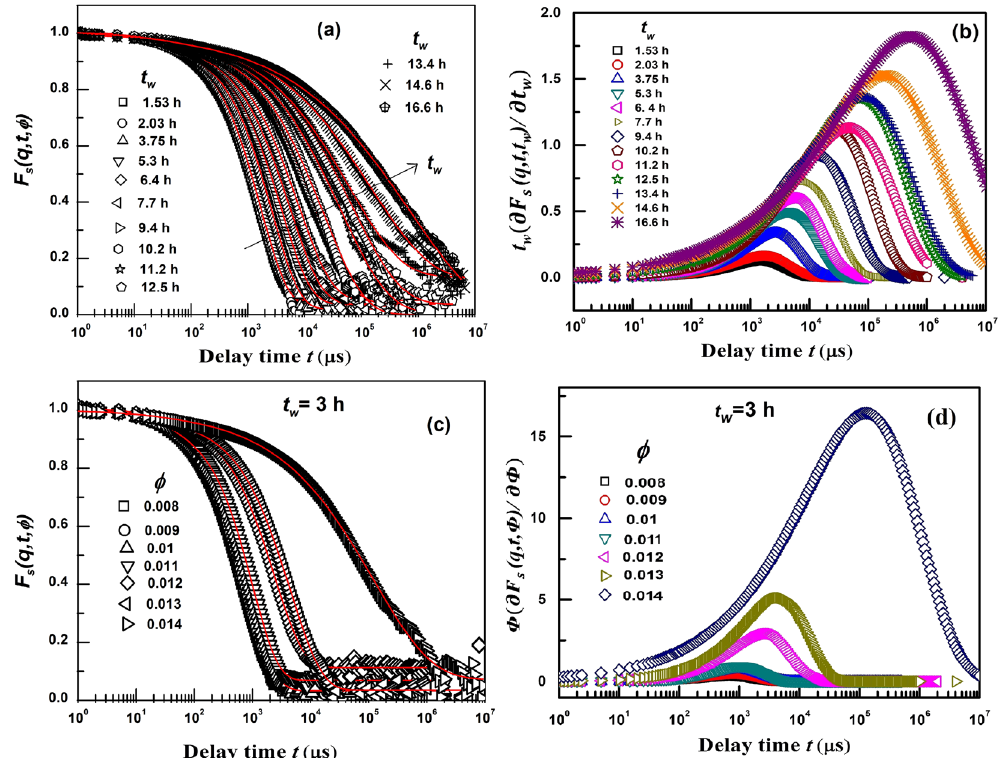
Figure 3. ( a ) F s ( q , t , t w ) decay curves at various t w for Laponite-PS suspensions (Laponite concentration C L = 3.0 wt.%, and PS volume fraction φ PS = 5.66 × 10 − 5 ). The solid lines are fits to Eq. 9. ( b ) Plots of χ t ) = t w ∂ F s ( q , t , t w )/ ∂ t w as a function of delay time t for curves shown in Fig. 3(a). ( c ) F s ( q , t , φ ) decay curves at various φ at t w = 3 h. The solid lines are fits to Eq. 10. (d) Plots of χ φ ( q , t ) = φ ∂ F s ( q , t , φ )/ ∂ φ as a function of delay time t for curves shown in Fig.